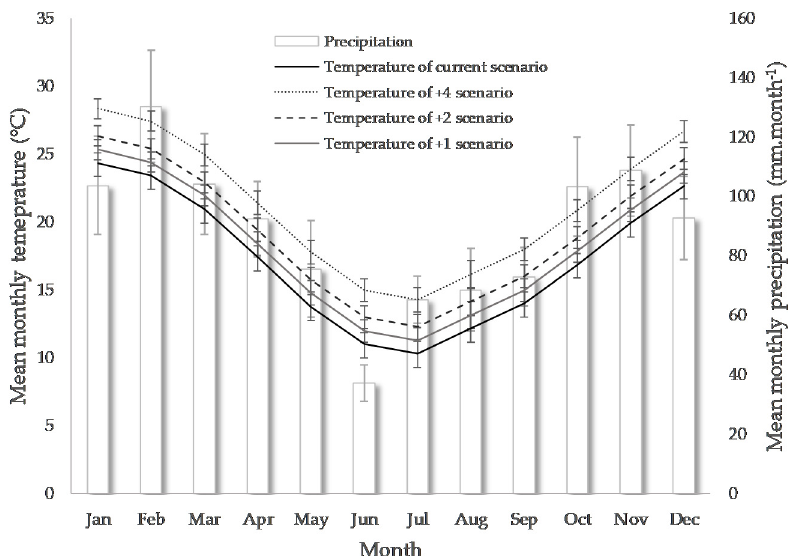
Figure 1. Variation of the mean monthly temperature in the current scenario, and in scenarios with 1, 2, and 4 °C increases of mean annual temperature. The columns represent the mean monthly precipitation, which remained the same in the different scenarios of increases in temperature. Values represent the average of 19 years of data (1999–2018). The bars represent the standard error.